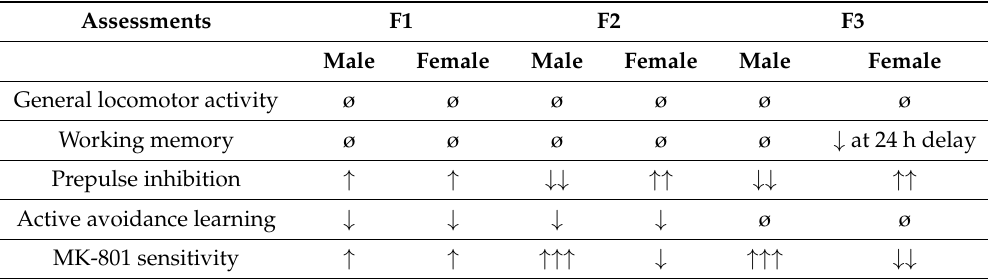
Table 1. Summary of the observed cognitive phenotypes in F2 and F3